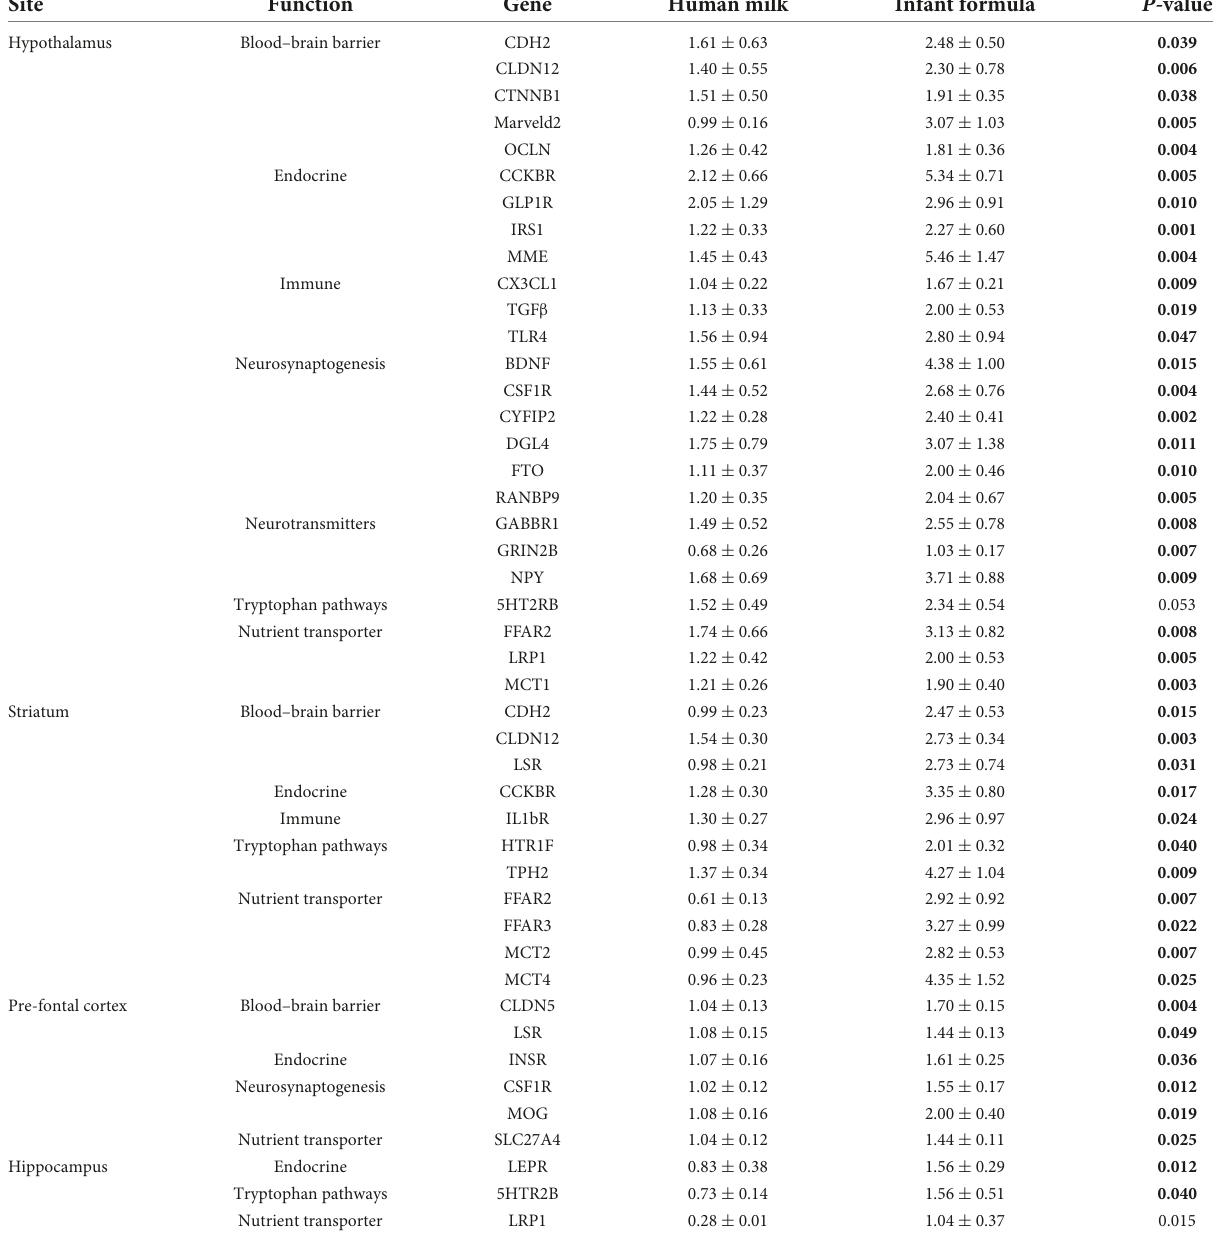
TABLE 6 Relative expression of differentially expressed genes ( p < 0.1) in four brain sites of HM- and IF-fed piglets (Mean ± SEM, significant p -values are in bold). Site Function Gene Human milk Infant formula